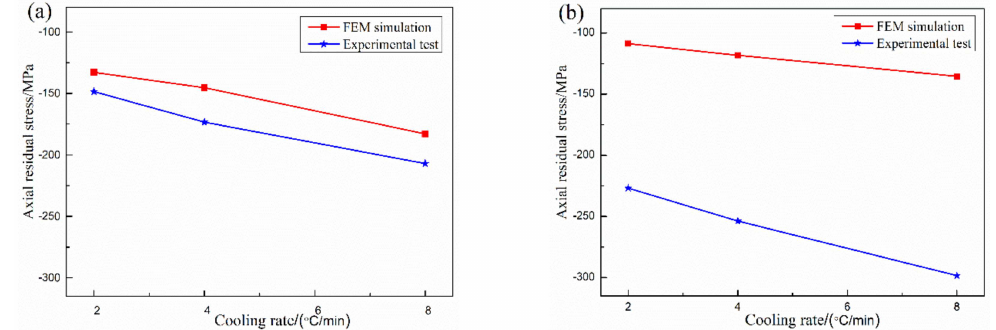
Figure 7. Residual stresses comparisons between the experimental test and the FEM simulation with di ff erent cooling rate: ( a ) the center area of joint, ( b ) the interface reaction layer near SiC